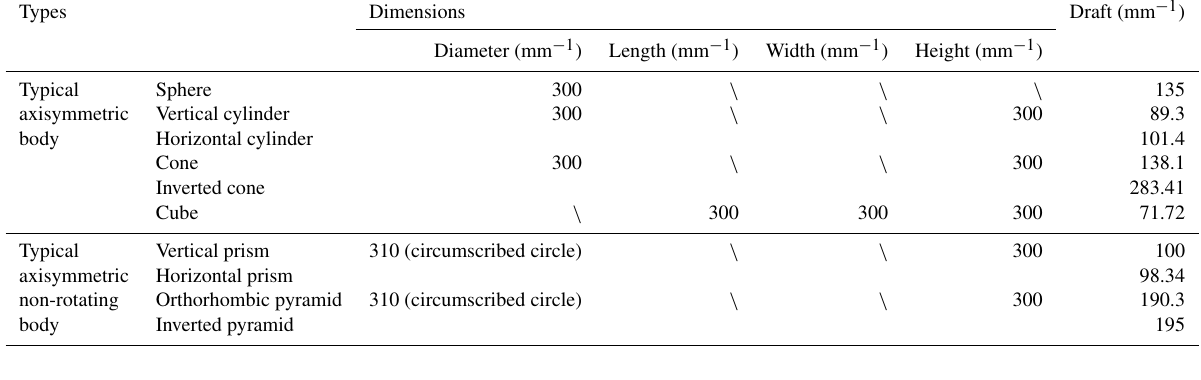
Table 2. Typical types and characteristic parameters of floating bodies on the water surface.